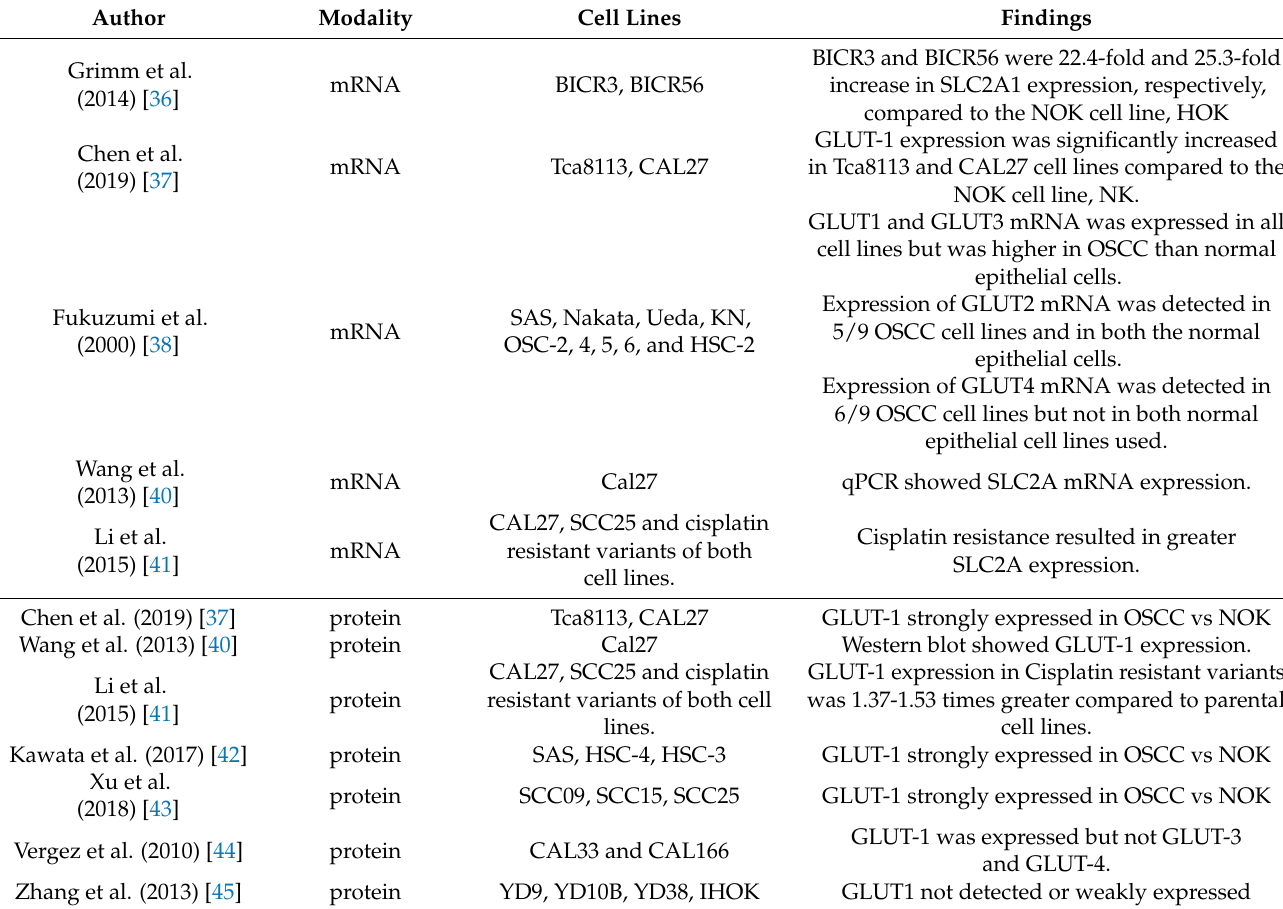
Table 1. GLUT1 in cell